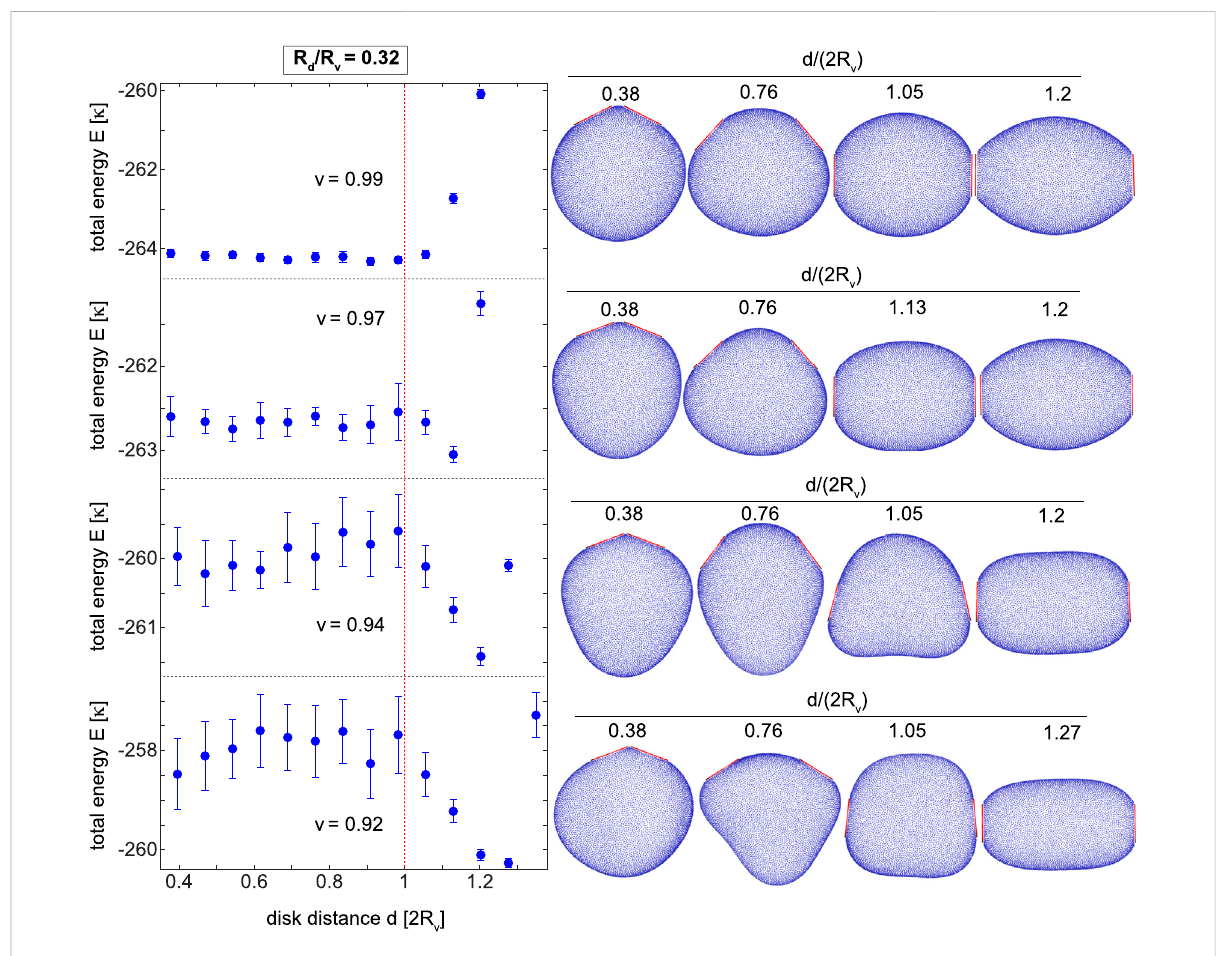
FIGURE 5 The total energy E / κ of de fl ated vesicles of different reduces volumes v =0.92 to v =0.99 with disks of fi xed size R d / R v =0.32 with some vesicle shapes on the right panel. Each point re fl ects the mean and the standard deviation of the total energy from ten simulations. The short-range interactions become neutral upon vesicle de fl ation and the long-range interactions become repulsive resulting in repulsive curvature-mediated forces between the disks. The stable elongated vesicle occurs at larger disk distances for vesicles with smaller